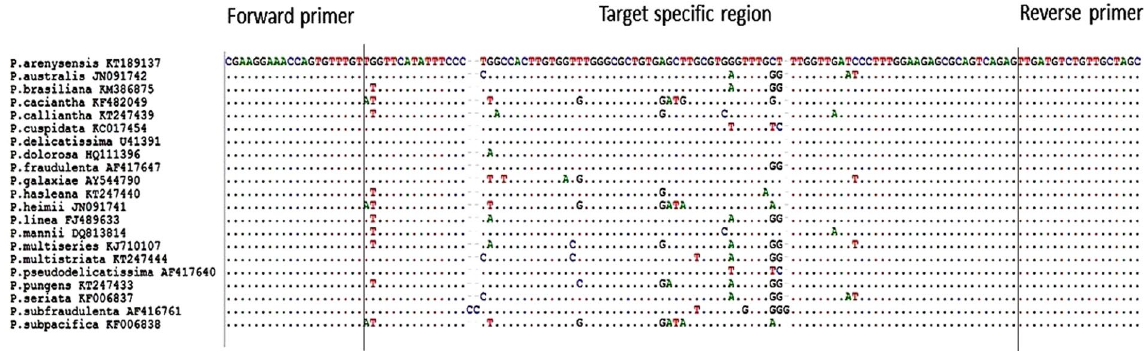
Figure 1. The alignment of consensus LSU rDNA sequences of 21 Pseudo-nitzschia species. The sequences were aligned using the Bioedit Sequence Alignment v. 7.0.5.3. The common forward and reverse primers flanked species-specific regions of the 21 Pseudo-nitzschia species considered under investigation. The target LSU rDNA amplified region was 130–133 bp in length and located in the 384 to 514 nucleotide